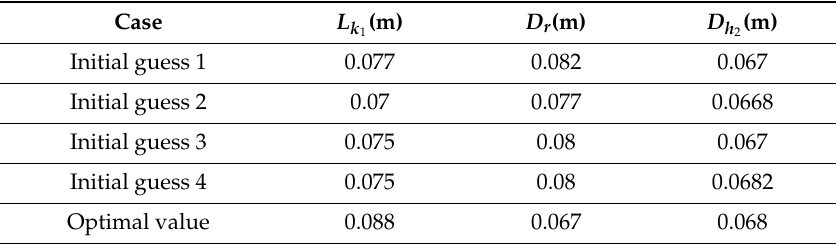
Table 8. Numerical values of initial guesses and the optimal